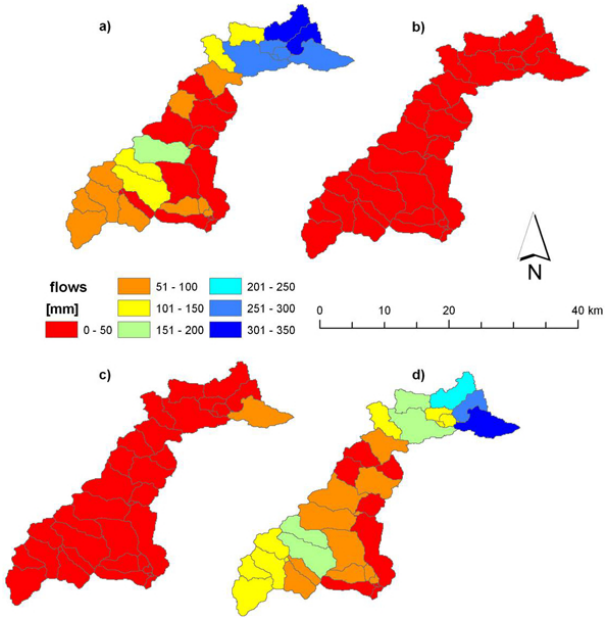
Fig. 4. Mean annual predicted groundwater flow for SWAT I (a) and SWAT II (c) and mean annual predicted lateral subsurface flow for SWAT I (b) and SWAT II (d)